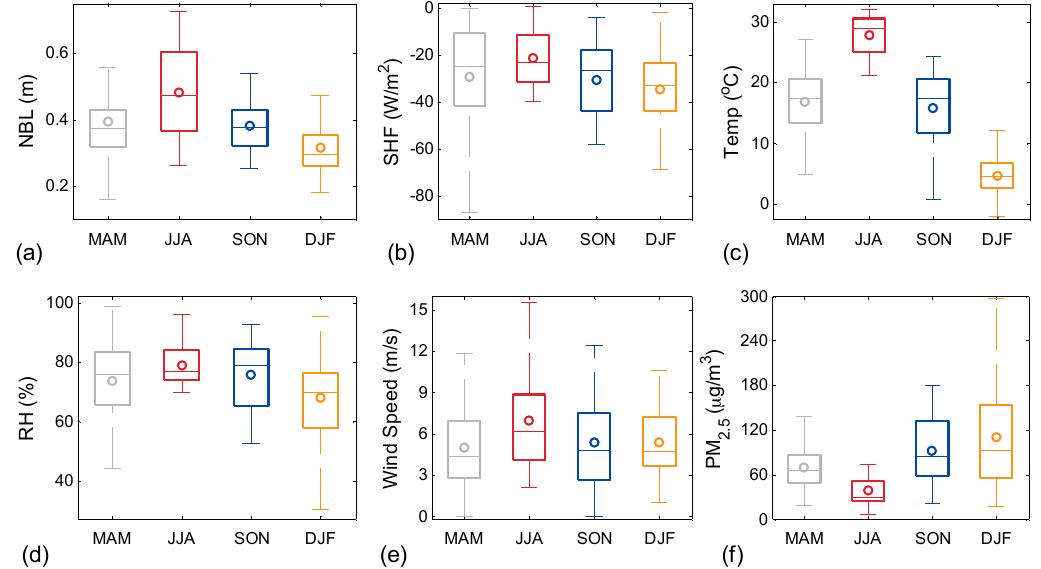
Figure 6. Corresponding mean seasonal variability based on the monthly-mean values for the period between December 2012 and June 2016 via box-and-whisker analyses. In each box solid line indicates the median and the extent of boxes, 25th and 75th percentiles. The central circle is the mean value, and the external short lines are the maximum and minimum. ( a – f ) represent seasonal variability of NBLH, SHF, surface temperature, relative humidity, wind speed and PM 2.5 , respectively.